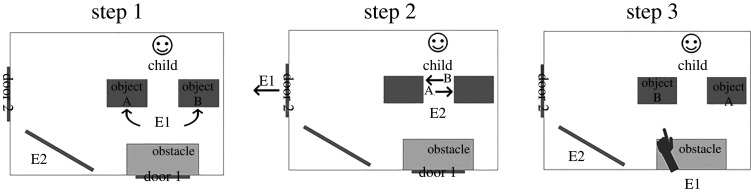
Basic set-up of the modified Sefo task in study 2a. Step 1: E1 puts two novel objects, each in one box while E2 is hidden behind a curtain. Step 2: after E1 left through door 2, E2 swaps the two objects. Step 3: E1 enters the room through door 1, points to one of the boxes and requests the infant for help.